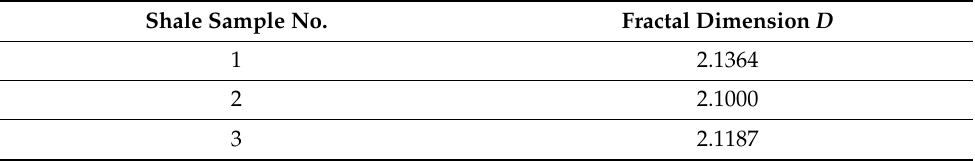
Table 3. Fractal dimension of shale fracture surface morphology. Shale Sample